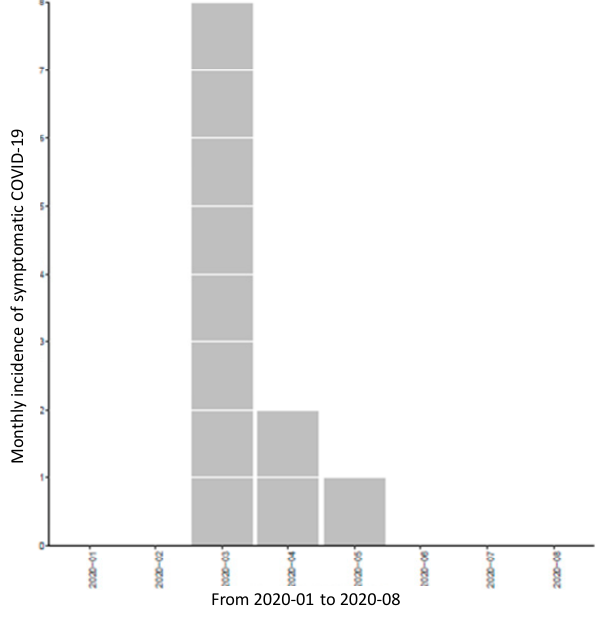
Figure 2. Epidemic curve of symptomatic COVID-19.